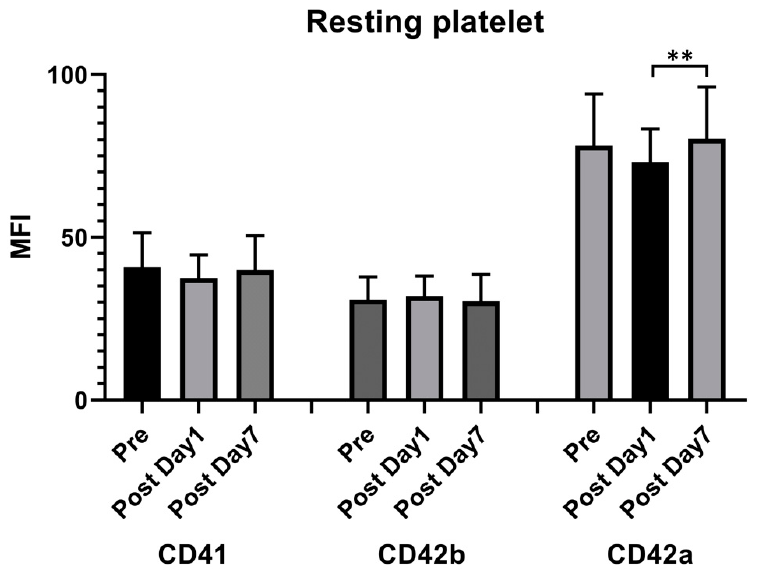
Figure 2. Resting platelet surface receptor expression following the ChAdOx1 nCoV-19 vaccine. Flow cytometry was used to measure the time course of the platelet surface expressions of CD42b, CD42a, and CD41. The presented values are the median fluorescence intensity (MFI) ± standard deviation. ** p <